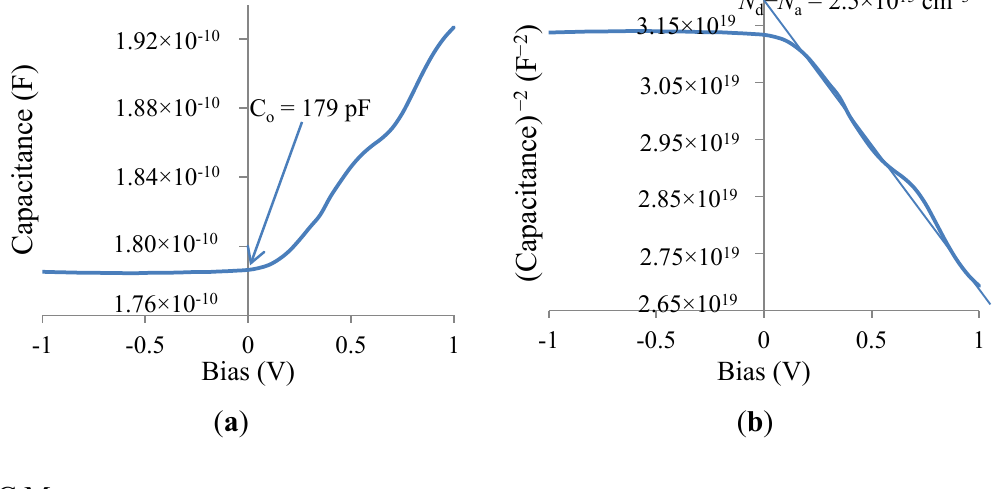
Figure 16. ( a ) Capacitance-Voltage plot and ( b ) corresponding Mott-Schottky plot for CdS/CdTe solar cell structure, when depletion width is less than the device